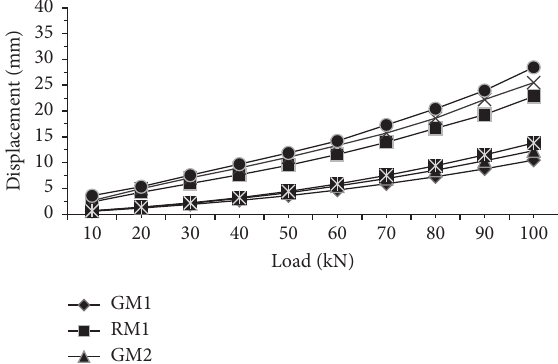
Figure 18: Simulated displacement-load curves of rigid and flexible piles.